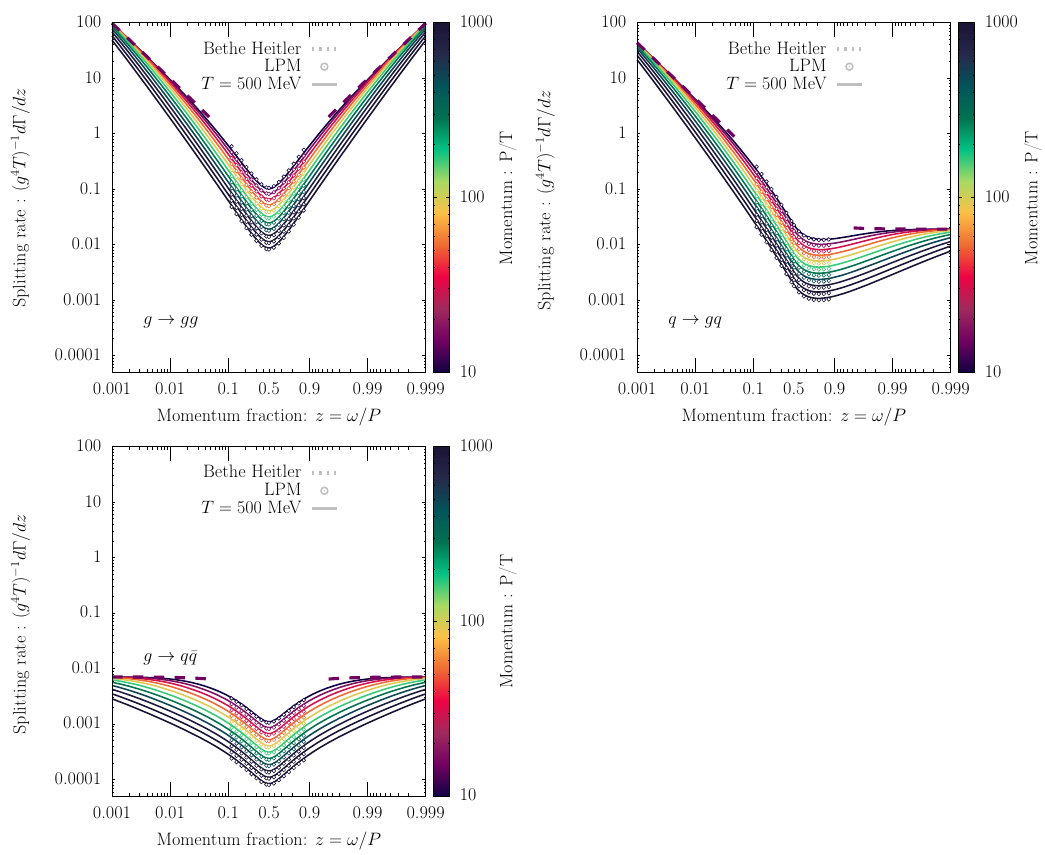
Figure 4. Momentum dependence of the splitting rate at T = 500 MeV (dashed blue lines) for the processes g → gg (top), q → gq (right), g → qq (bottom). Dashed lines and open circles correspond to the approximate rates in Bethe Heitler regime (3.8) and the deep LPM regime (3.12).